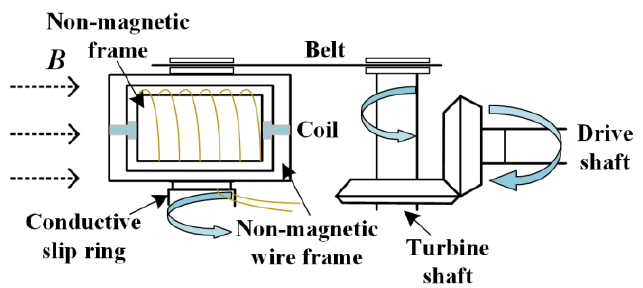
Figure 2. Coil probe structure diagram.